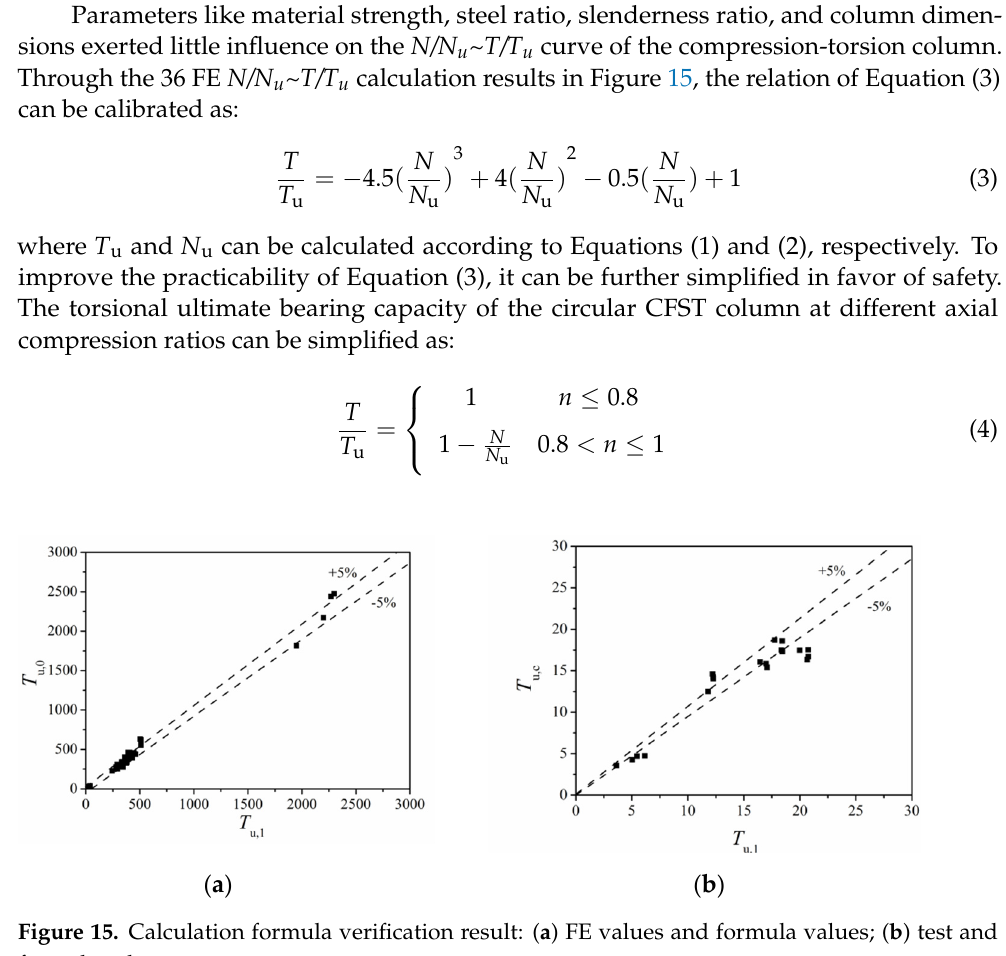
Figure 14. Effect of different column sizes.